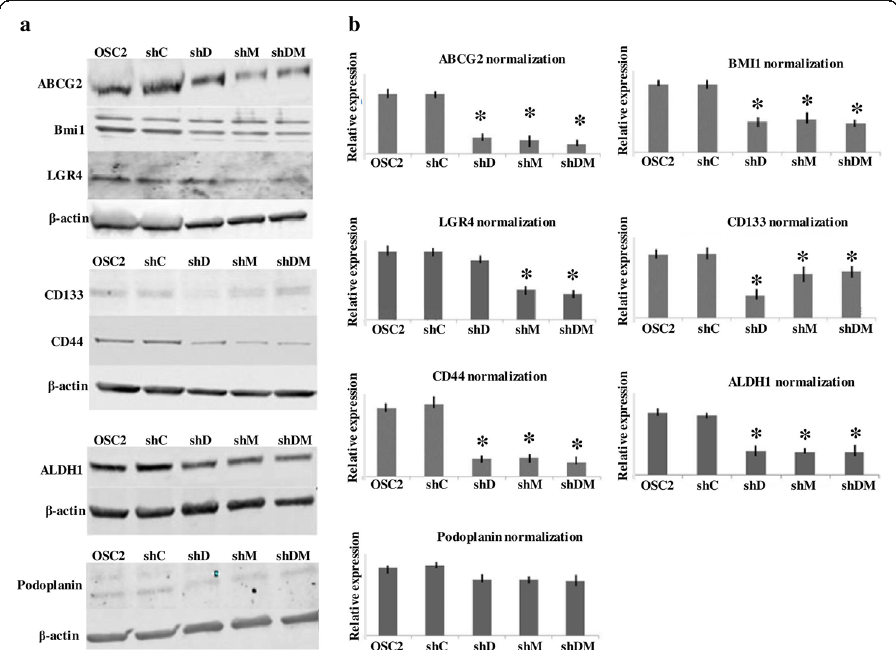
Fig. 2 Western blot (WB) analyses of OCSC markers in DSPP-MMP20 silenced OSC2 cells ( a ). Normalization of ALDH1, ABCG2, BMI1, Podoplanin (PDPN), CD44, CD133 and LGR4 protein levels was with β -actin . Y- (vertical) axis of histograms represent expression level for each protein relative to β -actin ( b ). OSC2 = parent (untreated) cells; shC = control (scramble sequence) cells; shD = DSPP silenced cells; shM = MMP20 silenced cells; shDM = combined DSPP-MMP20 silenced cells. * p < 0.05 compared with ShC. Experiments were performed in